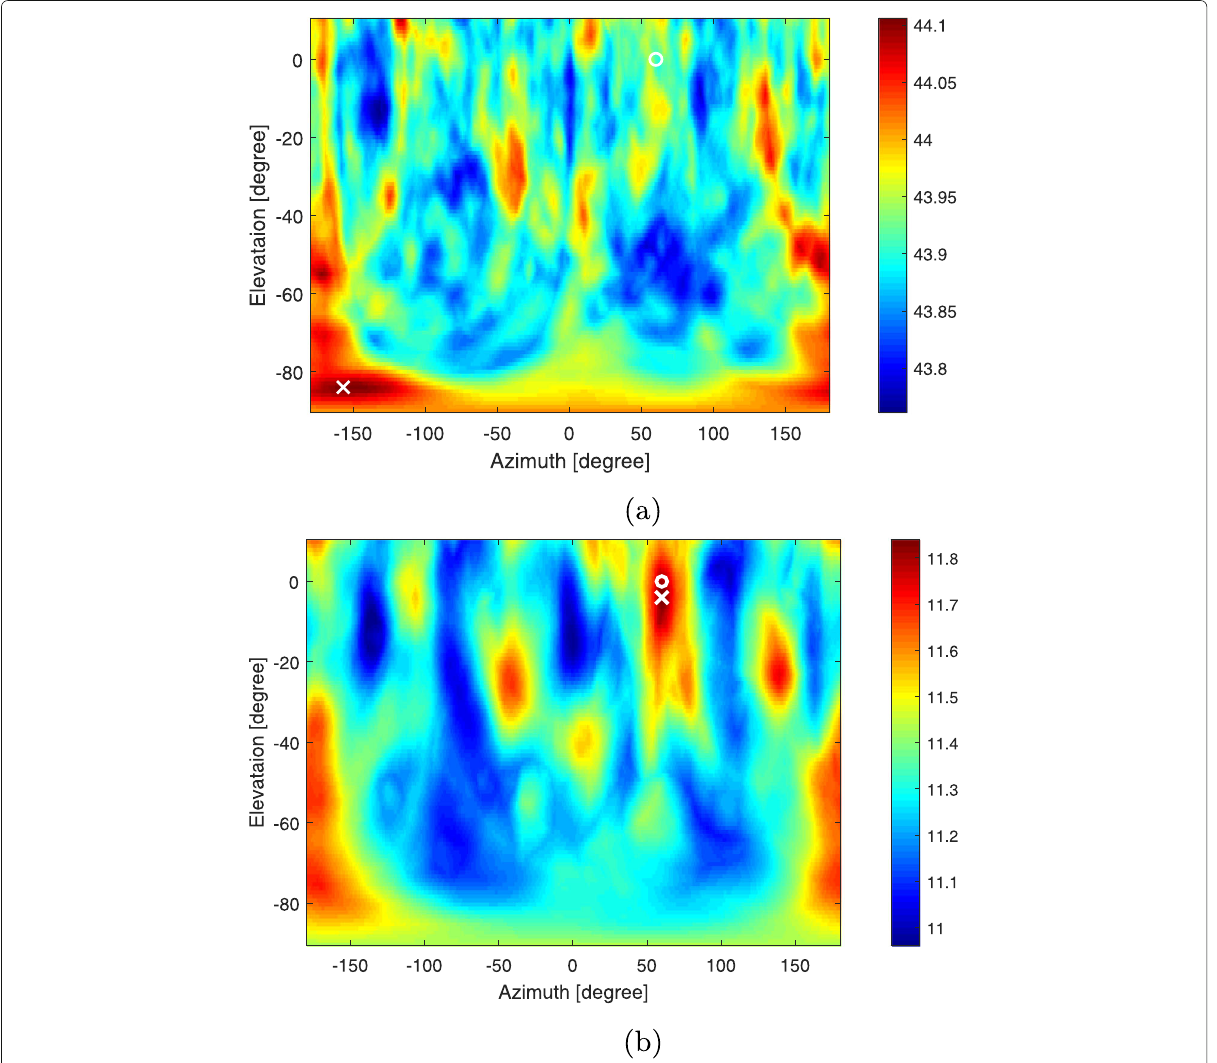
Fig. 9 SNR angular spectral response (dB) from SPCup hovering UAV (task 1) case 297 a w/o SNR response scaling and b w/ SNR response scaling, using MVDR with max aggregation. Circle ( ◦ ) and cross ( × ) in the diagram represent the ground truth and the algorithm’s estimated peak response location,